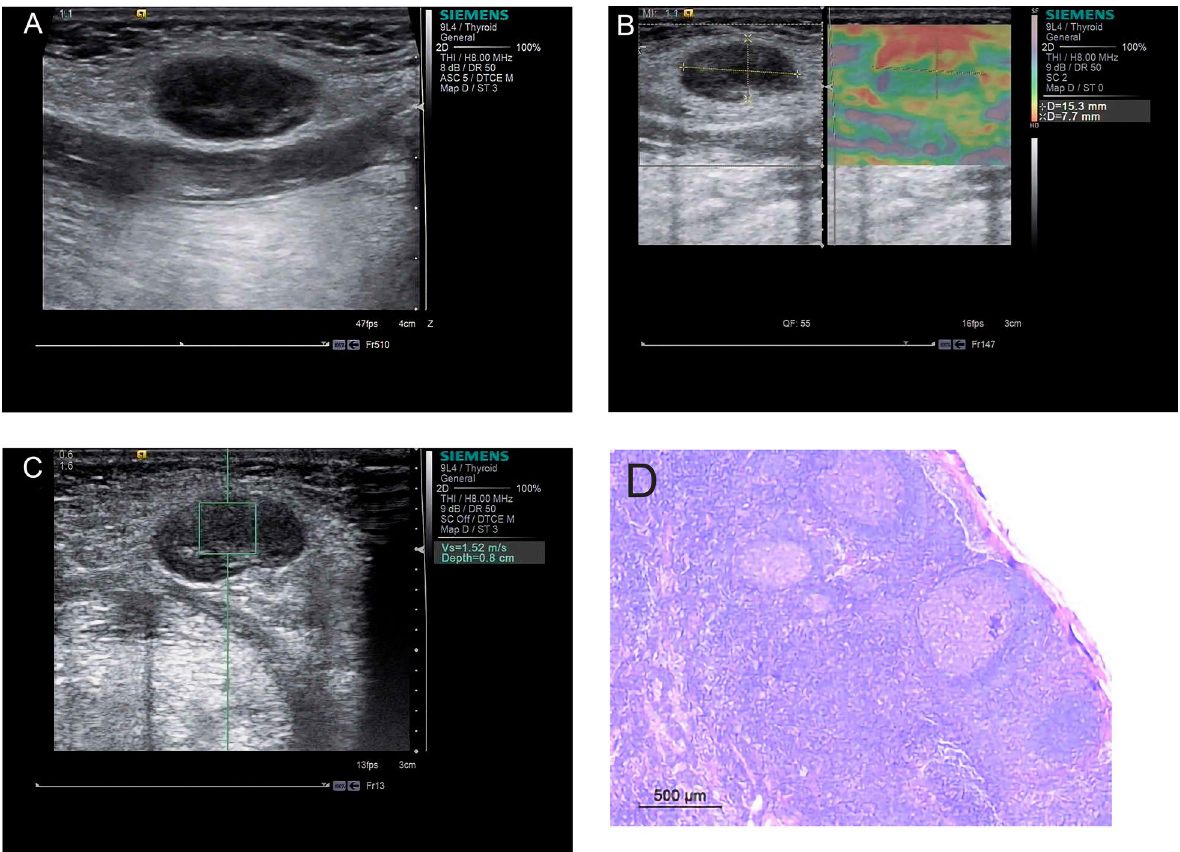
Fig. 2 Benign cervical lymph node correctly diagnosed by SE and ARFI. A Grayscale US image of LN showing absent echogenic hilum. B Corresponding SE image showed total red area less than 50% consistent with elasticity scale 2. C Acoustic radiation force impulse (ARFI) measurements showed SWV of 1.52 m/sec. D A low power view of reactive follicular hyperplasia in a sentinel LN showing a preserved nodal architecture and lymphoid follicles that are highly variable in size and shape. Margins of the follicles are sharply defined and surrounded a mantle layer of small lymphocytes and separated by abundant inter follicular tissue. (H&E, ×